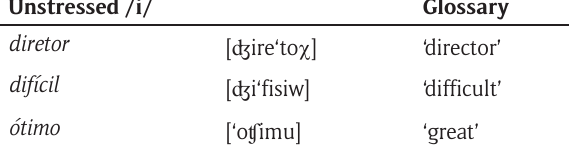
Table 3: Palatalization of /t/, /d/ before unstressed /i/.